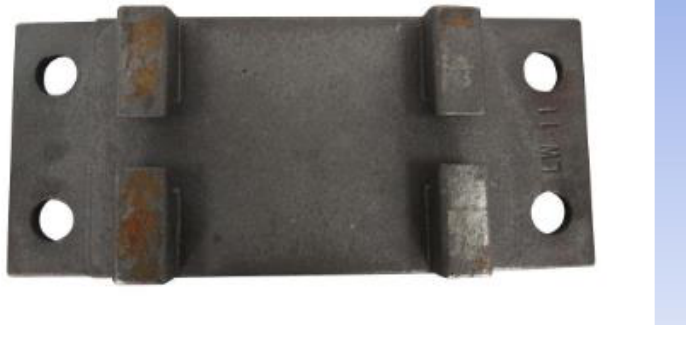
Table 10. Effects of improvement on damage occurrence and sensitivity following performance improvements of a specific components.